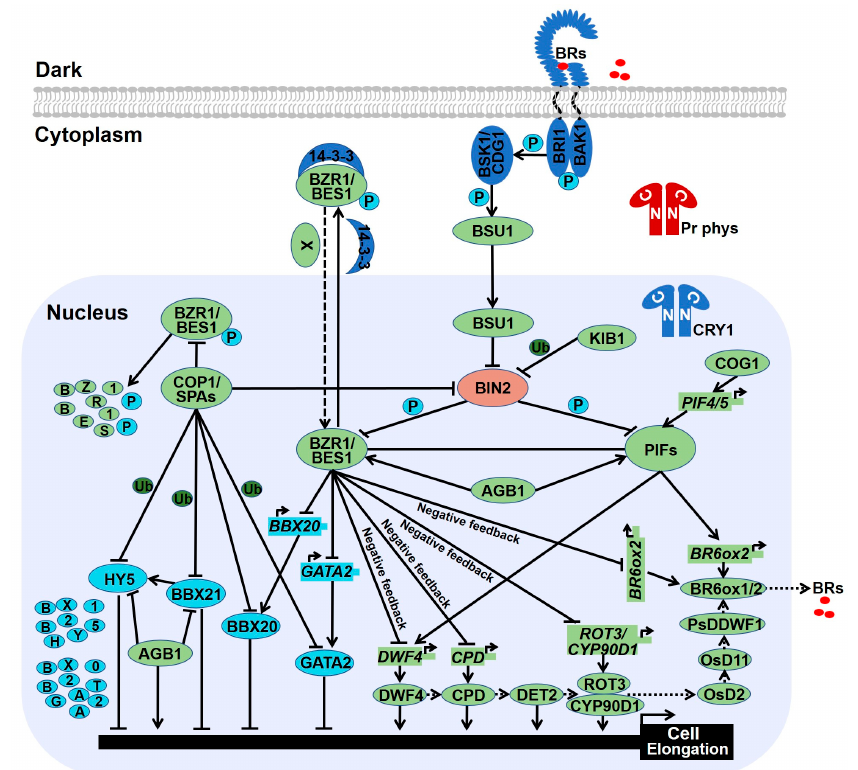
Figure 3. Brassinosteroids regulate skotomorphogenesis in the dark. In the absence of BR, constitutively active BIN2 not only phosphorylates BZR1 and BES1 to restrict their transcriptional activities, but also phosphorylates PIF3 and PIF4 to stimulate their degradation. Phosphorylated BZR1 and BES1 prefer to interact with 14-3-3 proteins which restrain them in the cytoplasm, whereas PP2A-mediated dephosphorylation of BZR1 and BES1 accelerate their nuclear accumulation. In the presence of BR, BR-bound BRI1 recruits BAK1 to initiate their transphosphorylation which activates BSK1 and CDG1. The activated CDG1 phosphorylates BSU1 which in turn dephosphorylates and inactivate BIN2. The inactivated BIN2 releases BZR1 and BES1, as well as PIF3 and PIF4. In addition, AGB1 not only interacts with BES1 to improve the ratio and transcriptional activity of dephosphorylated BES1, but also associates with PIF3 to block its degradation. COG1 directly binds to the promoters of PIF4 and PIF5 to upregulate their transcription. PIF4 and PIF5 can directly bind the promoters of DWF4 and BR6ox2 to enhance BR biosynthesis. Several critical enzymes have been identified in the BR biosynthesis pathway, including DWF4, CPD, DET2, ROT3, OsD2, OsD11, PsDDWF1, and BR6ox1/2. When the BR reaches certain levels, BZR1 and BES1 arrest the transcriptional levels of DWF4 , CPD , ROT3 , and BR6ox1/2 via a negative feedback loop. In the dark, activated COP1-SPAs complex promote skotomorphogenesis by triggering photomorphogenesis-promoting factors such HY5, BBX21, BBX20, and GATA2 for ubiquitination and degradation. Meanwhile, phosphorylated BZR1 and BES1 are degraded in a COP1 dependent manner, resulting in the high ratio of dephosphorylated BZR1 and BES1 which also contribute to skotomorphogenesis.